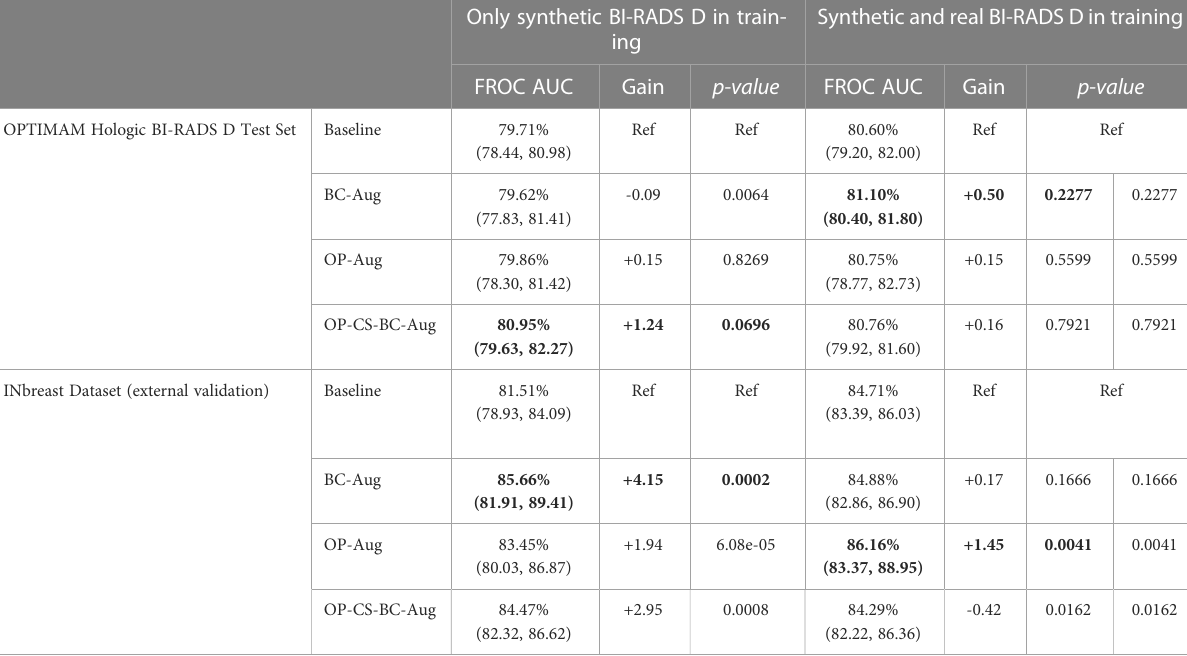
The columns on the left correspond to the models trained without real BI-RADS D mammograms. The baseline models were trained without synthetic images. The 95% Con fi dence IntervalsoftheFROCAUCareinparenthesis.The p-value wascomputedusingtheDeLongmethodwithamaximum of10FPPI.Boldvaluescorrespondtothebestperformingstrategy. Ref corresponds to the reference